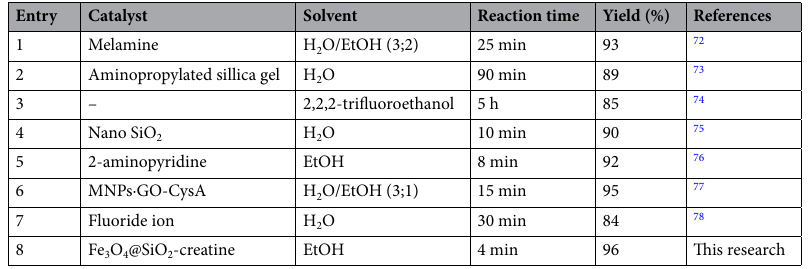
Table 4. Comparison of the catalytic ability of Fe 3 O 4 @SiO 2 -creatine with previous reports for synthesis of 4c .